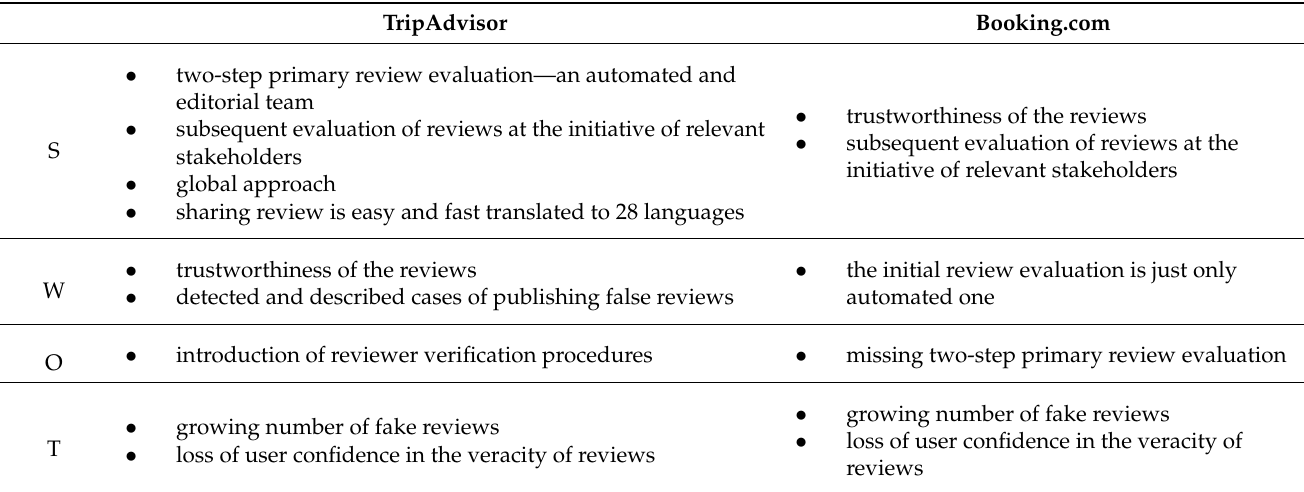
Table 1. A SWOT analysis of review verification processes of TripAdvisor and Booking.com review sites.